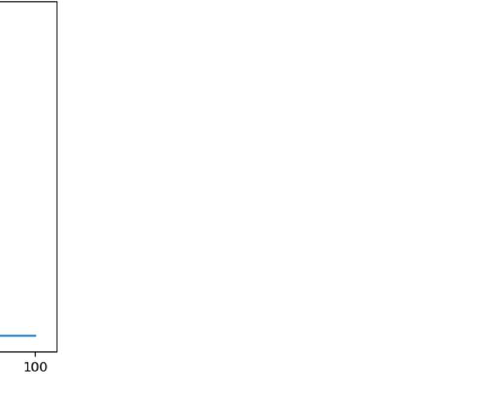
Figure 6. Travel time estimation results of hourly density distribution. To verify the effectiveness of the method, a method that does not consider the results of DBSCAN and directly performs interpolation is selected for comparison. Five thousand points are randomly chosen from the travel time data to estimate the travel time. The di- rect interpolation method and the interpolation method based on the DBSCAN results are used for comparative analysis. The results are shown in Figure 7. The abscissa is the actual value of the travel time, and the ordinate is the estimated value. The regression equations of the estimated and actual values of the two methods are, respectively: (1) The direct interpolation method: